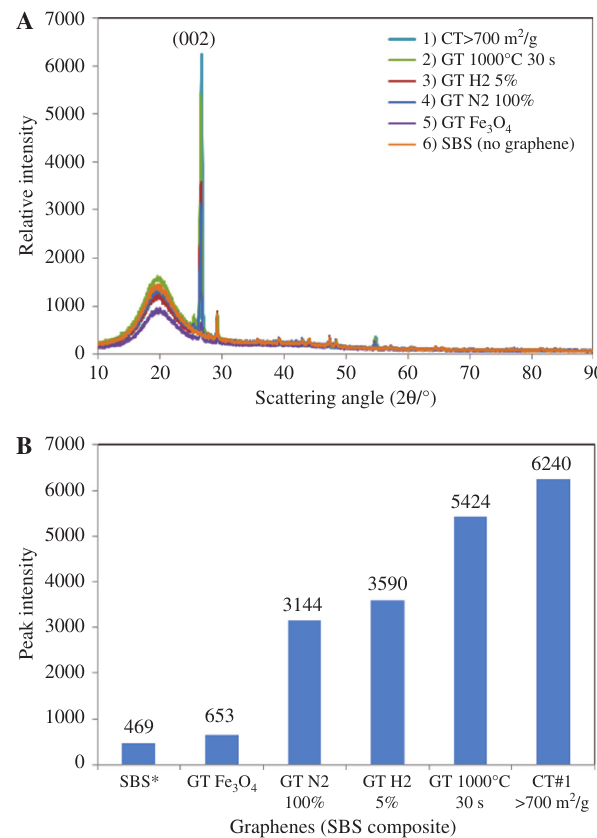
Figure 7 (A) Diffractogram: relative intensity versus scattering angle of SBS-G/graphene composites (listed in order of peak inten- sity) and (B) graphenes (in SBS) versus peak (002) intensity.